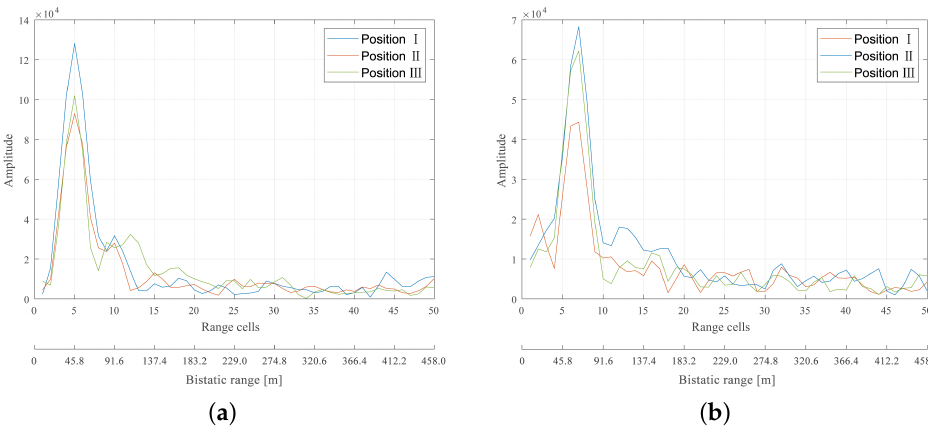
Figure 7. Correlation peaks of three positions after range compression and coherent accumulation. ( a ) C01 observation ( b ) C04